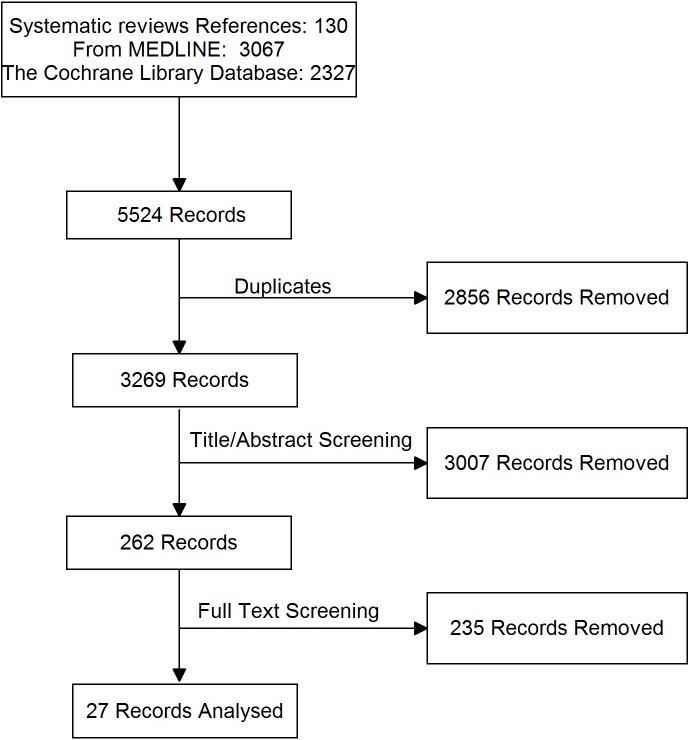
PRISMA flow diagram for RCTs in a systematic review of triple therapy in type 2 diabetes.Flow diagram showing the total number of records identified and the number of records filtered at each stage of the selection process from the systematic search for randomised control trials of type 2 diabetes in November 2014.